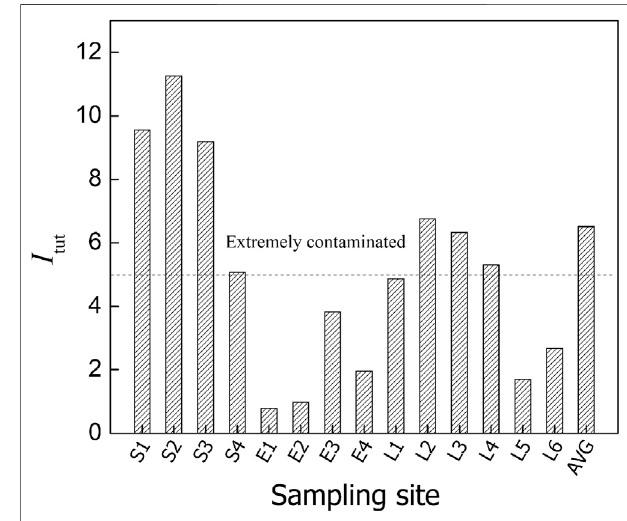
FIGURE 2 | I geo of heavy metals in the surface sediments of the Minghu Wetland.